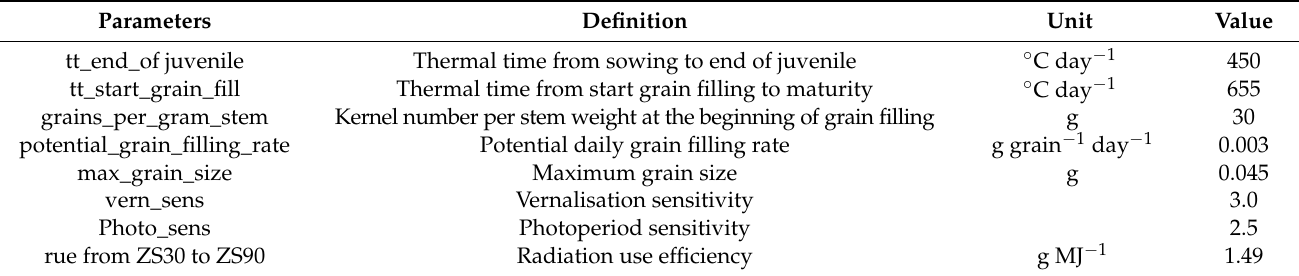
Table 3. Calibrated genetic parameters of a winter wheat,